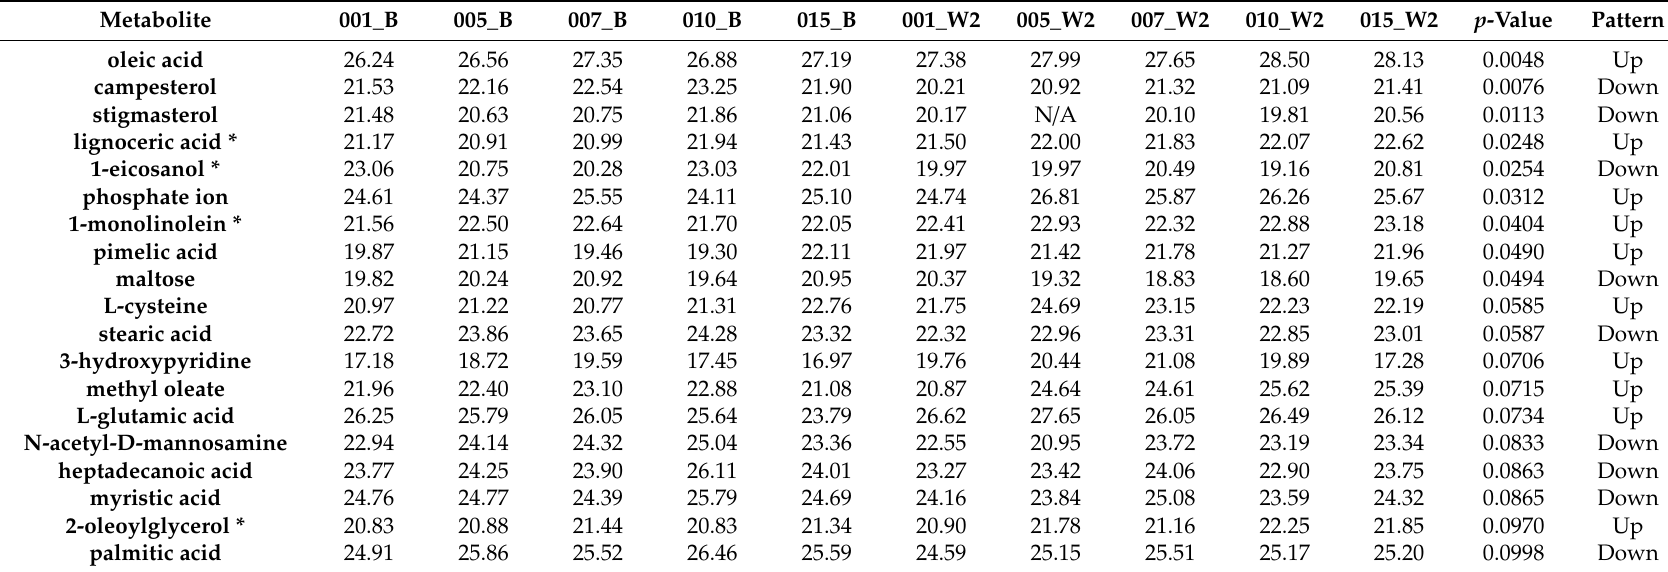
Table 4. List of significant metabolites: comparison of baseline (B) and the 2nd week (W2) and their peak area values (Log 2